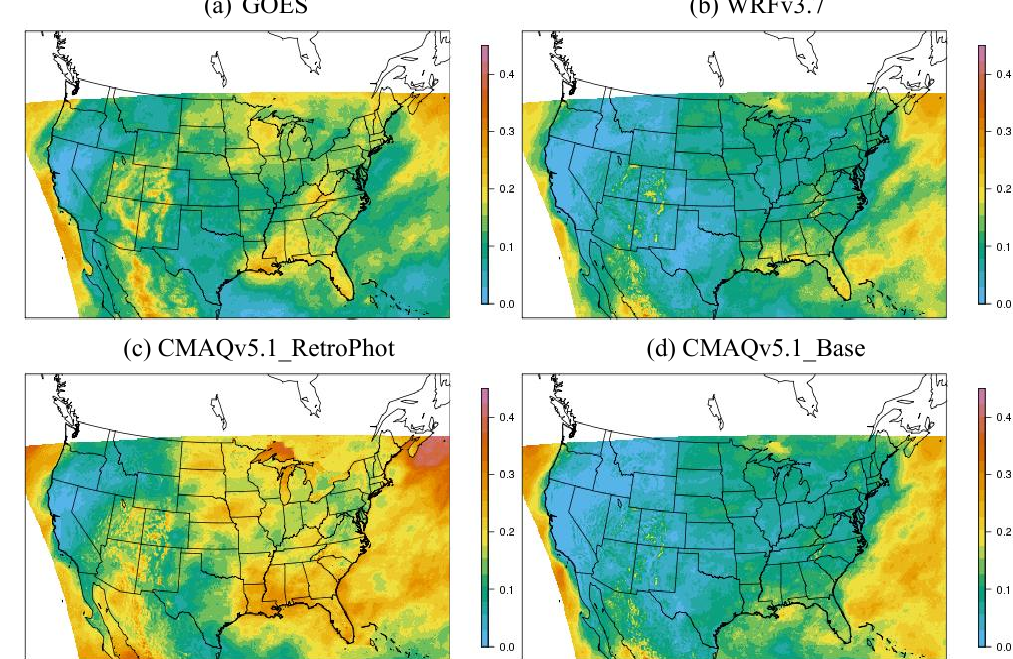
Figure 4. The average cloud albedo during daytime hours in July 2011 derived from (a) the GOES satellite product (b) WRF3.7 (c) CMAQv5.1 with photolysis/cloud model treatment from v5.0.2 and WRF3.7 inputs (CMAQv5.1_RetroPhot) (d) CMAQv5.1 using WRF3.7 inputs (CMAQv5.1_Base).